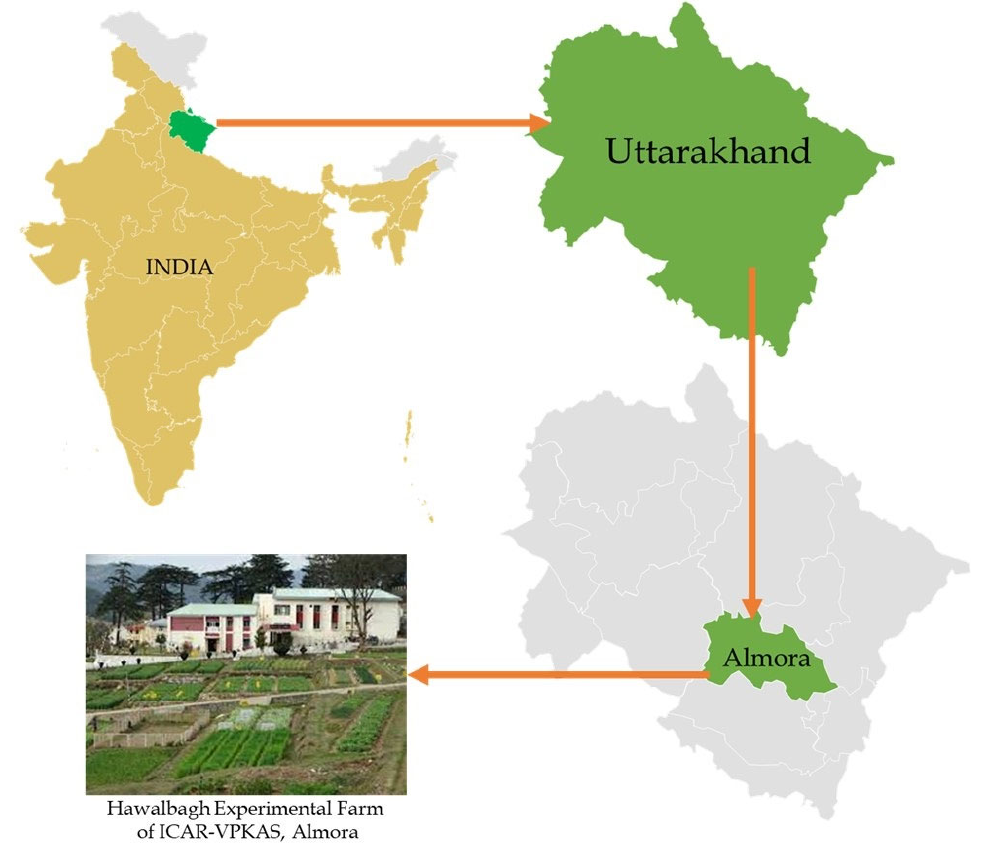
Figure 1. Long ‐ term experimental site of rice–wheat cropping system. Figure 1. Long-term experimental site of rice–wheat cropping